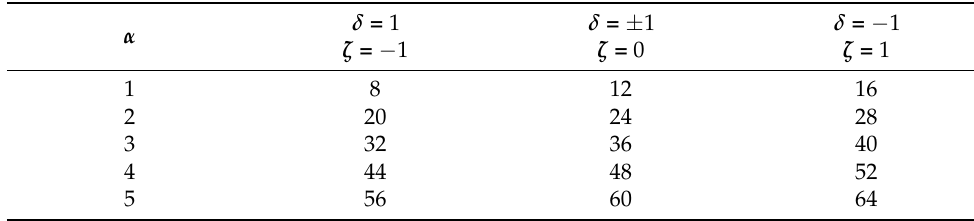
Table 1. Rotor slots number z of an induction